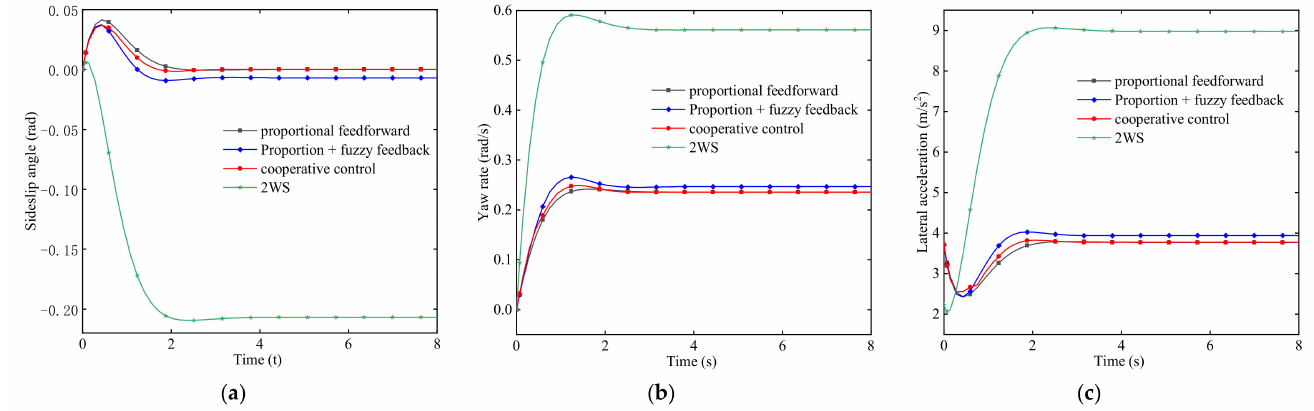
Figure 12. Comparative analysis. ( a ) Sideslip angle. ( b ) Yaw rate. ( c ) Lateral